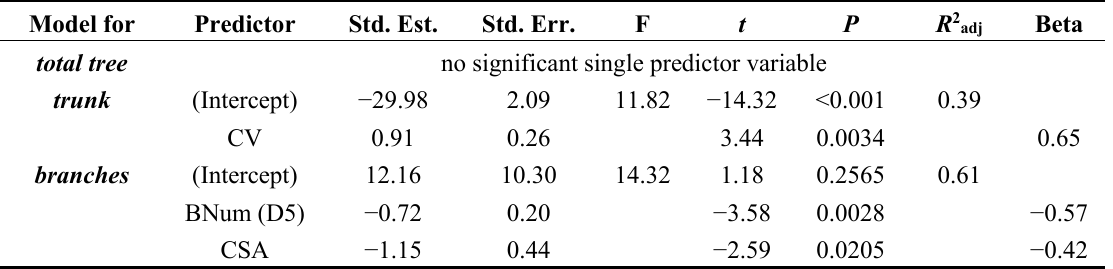
Table 4. Final results of the stepwise multiple regression models with relative difference